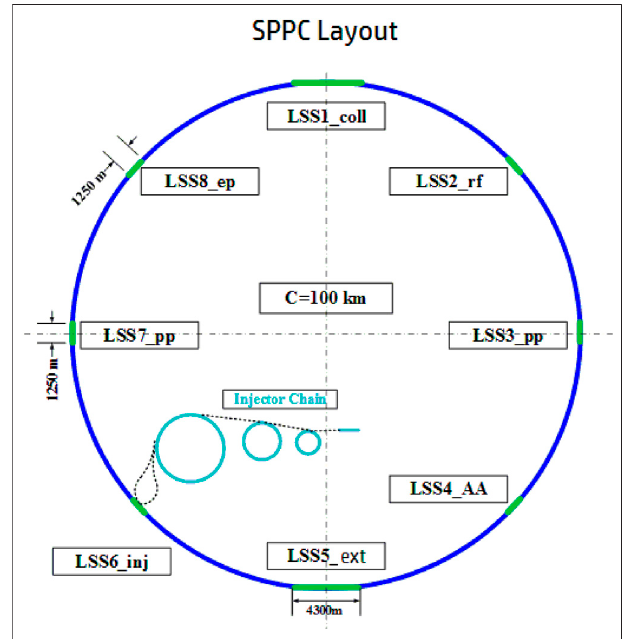
FIGURE 1 | SPPC accelerator